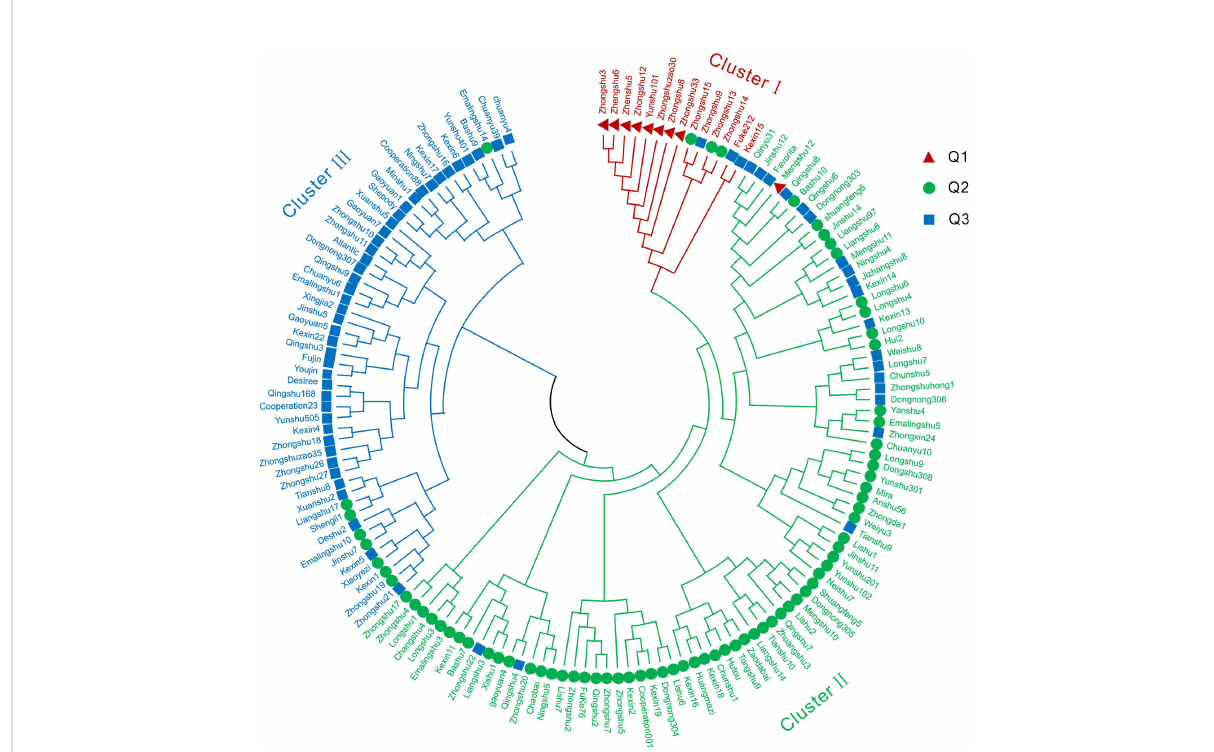
FIGURE 4 Phylogenetic tree of 149 potato varieties. A phylogenetic tree of all 149 potato varieties analyzed using 24 SSR markers was constructed by the neighbor-joining method. Cluster I included 14 varieties shown in red, cluster II included 85 varieties shown in green, and cluster III contained 50 varieties shown in blue. Q1, Q2 and Q3 represent the three groups of classi fi cation results of Structure analysis.